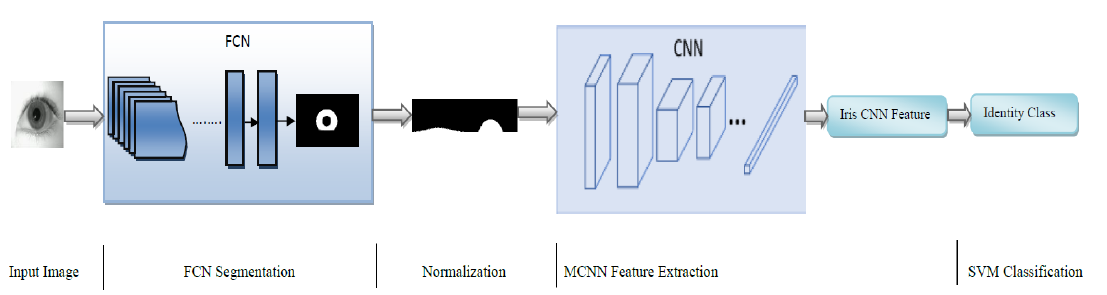
Figure 9. The framework for iris recognition using SVM